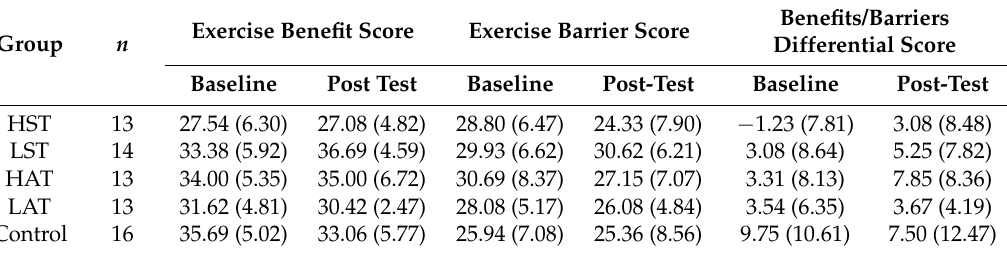
Table 3. Mean (SD) for measures stratified by group and